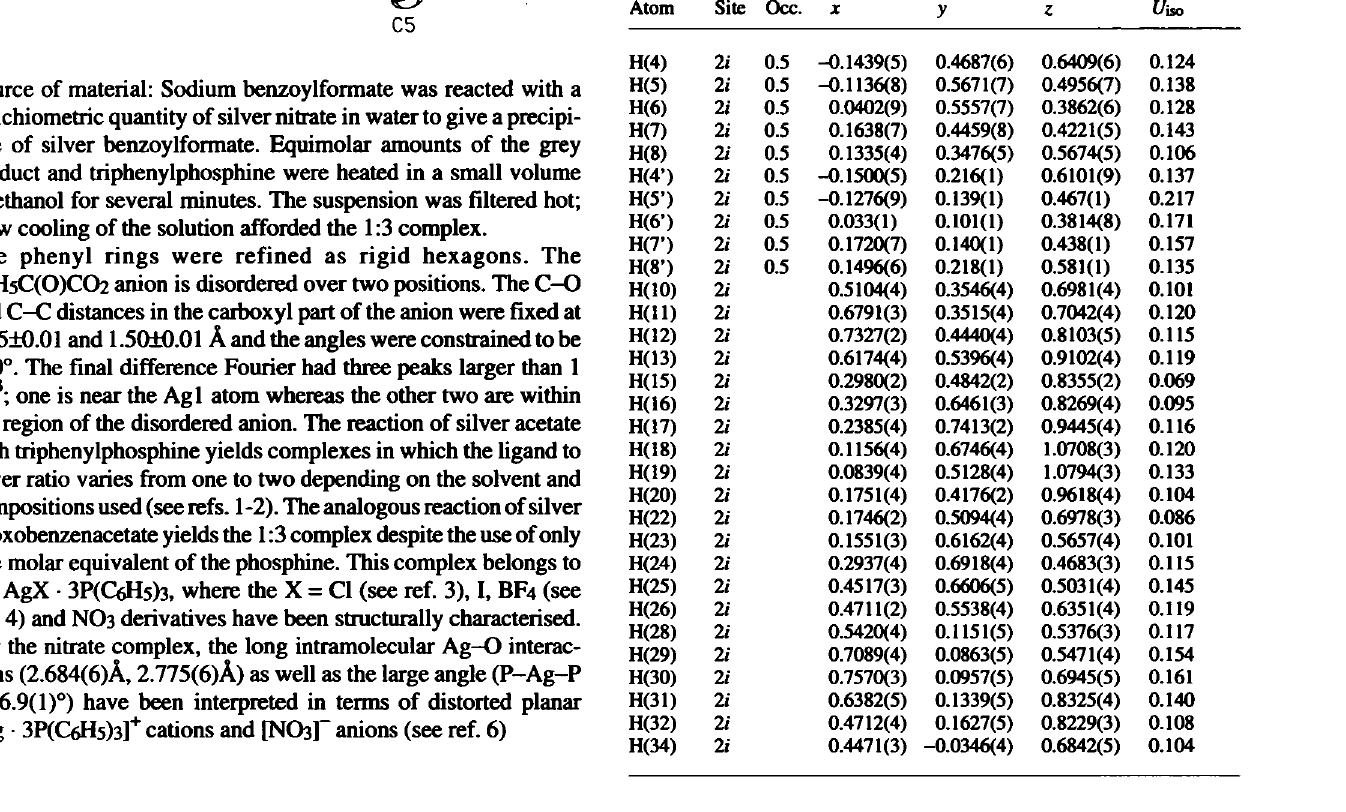
Table 2. Final atomic coordinates and displacement parameters (in Â 2